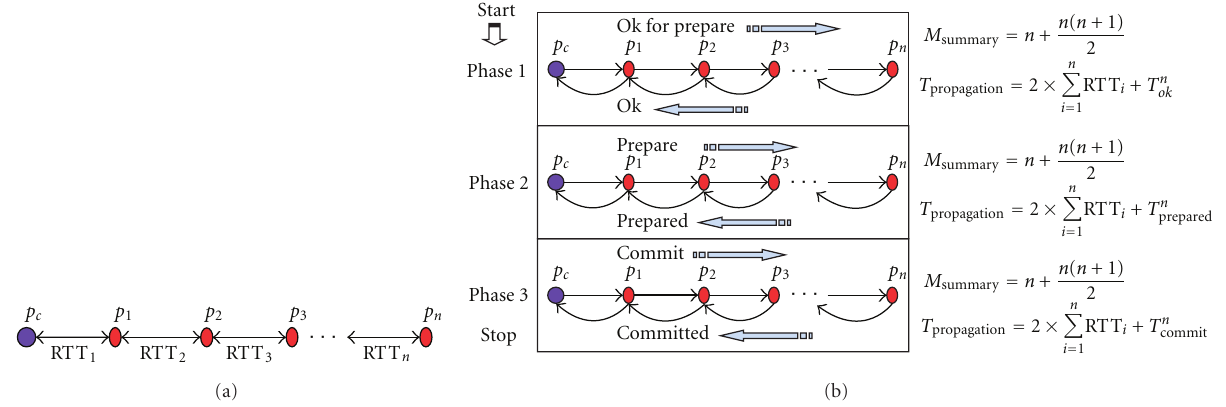
Figure 3: (a) Connection topology and (b) the abstraction of 3-phase commit protocol.